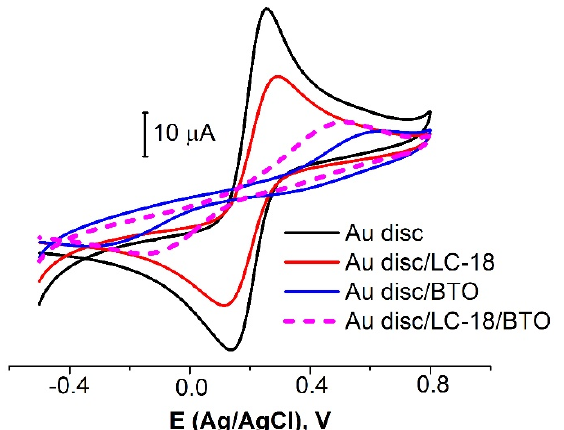
Figure 4. CVs for bare Au disc electrode (black curve) and electrodes with LC-18 aptamer layer (red curve), BTO layer (blue curve), and a layer of both aptamer and BTO (dashed curve). Solution: 0.025 M K 3/4 [Fe(CN) 6 ] in PBS (7.4).